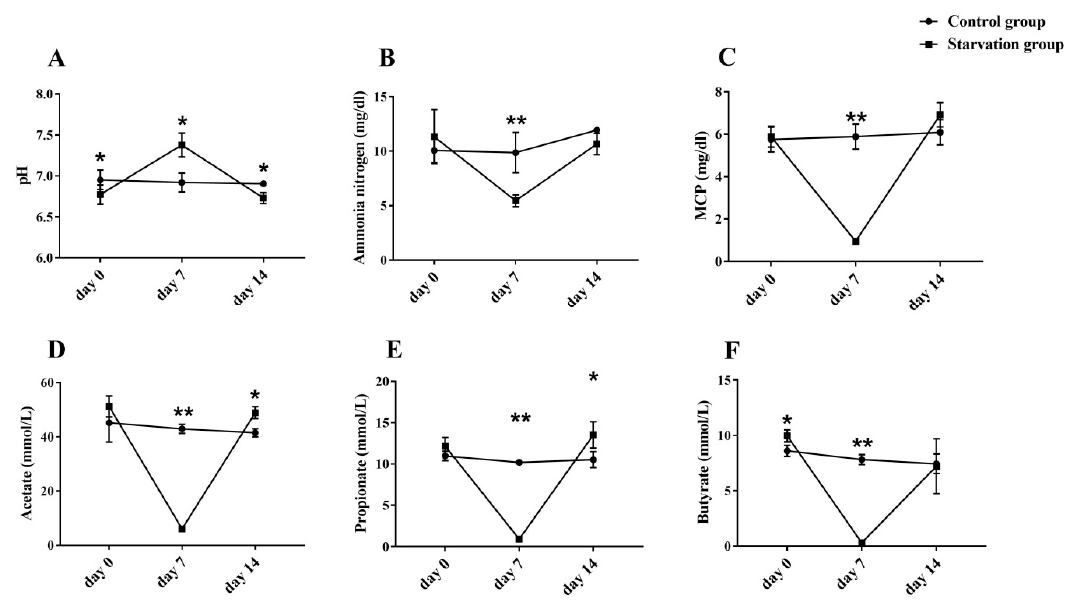
Figure 2. E ff ects of starvation and refeeding on the rumen fermentation parameters of yaks. ( A ) Figure 2. Effects of starvation and refeeding on the rumen fermentation parameters of yaks. MCP, pH; ( B ) ammonia nitrogen (mg / dL); ( C ) MCP, microbial protein (mg / dL); ( D ) acetate (mmol / L); ( E ) microbial protein. Values are means ± SD ( n = 6). Differences were represented by * p < 0.05 and ** p < propionate (mmol / L); ( F ) butyrate (mmol / L). Values are means ± SD ( n = 6). Di ff erences were represented 0.01. by p < 0.05 and * p <